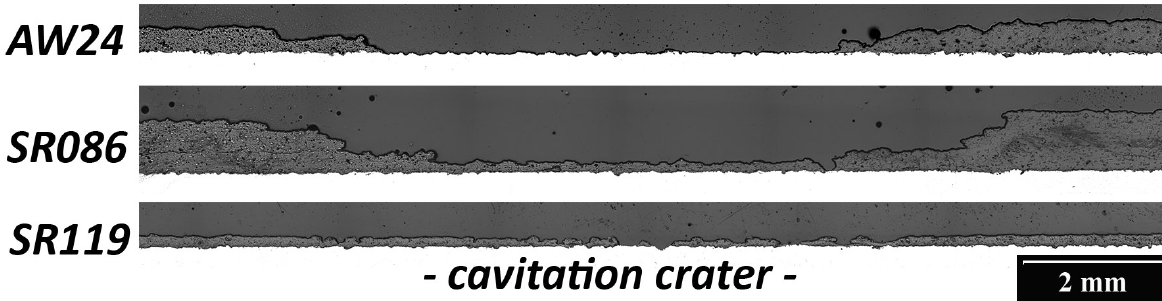
Figure 6. Cross-sections through cavitation crater after the test. Light